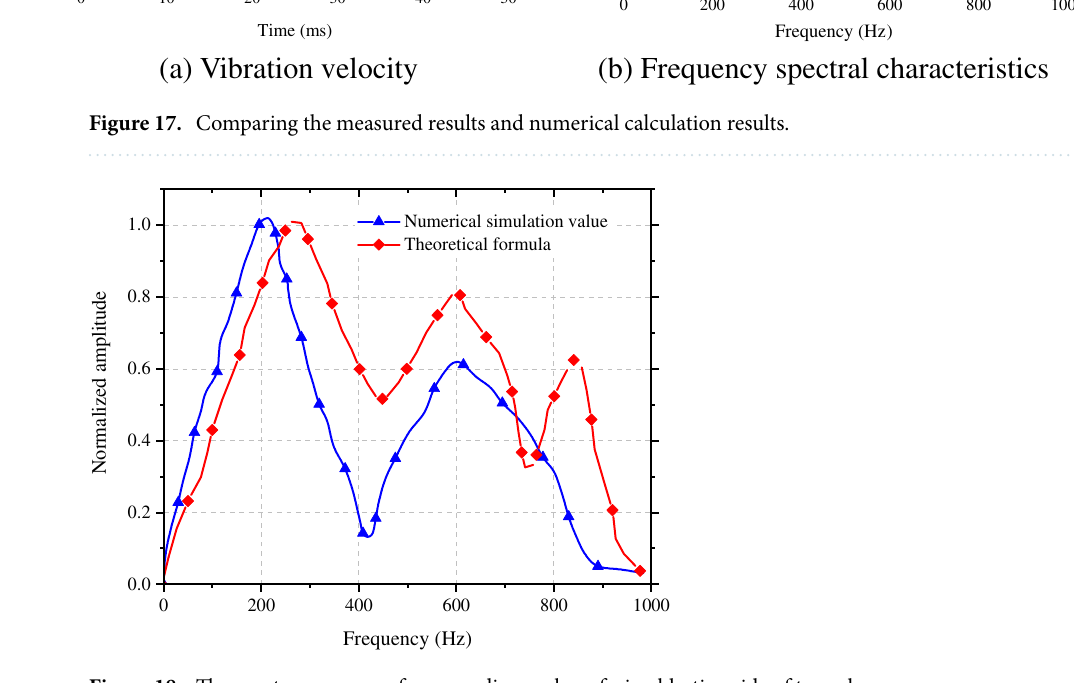
Figure 18. The spectrum curves of surrounding rock on facing blasting side of